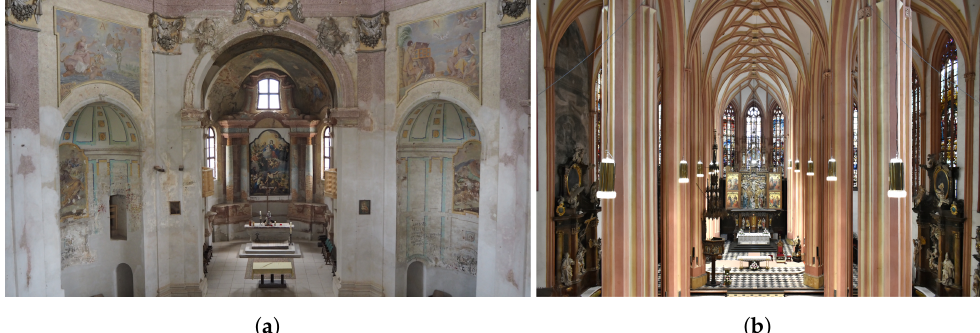
Figure 4. Interior of churches in which the proposed UAV system was deployed. ( a ) St. Anne and St. Jacob the Great Church in Stará Voda. ( b ) St. Maurice Church in